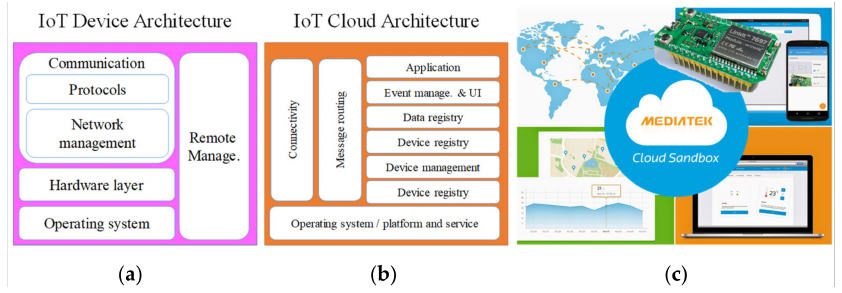
Figure 6. The sensor extension to the IoT: ( a ) IoT, ( b ) cloud, ( c ) Smart-chip connect to cloud.